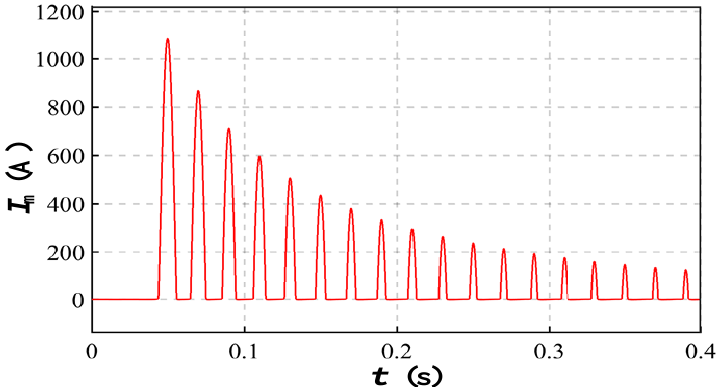
former closing at 180°.